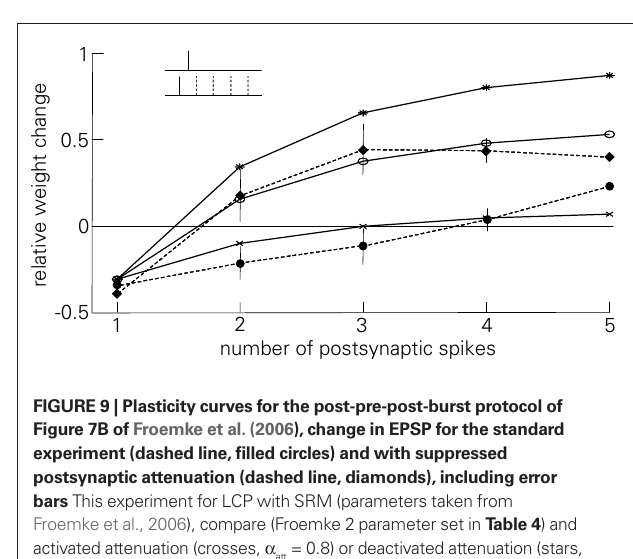
FigurE 9 | Plasticity curves for the post-pre-post-burst protocol of Figure 7B of Froemke et al. (2006), change in EPSP for the standard experiment (dashed line, filled circles) and with suppressed postsynaptic attenuation (dashed line, diamonds), including error bars This experiment for LCP with SRM (parameters taken from Froemke et al., 2006), compare (Froemke 2 parameter set in Table 4 ) and activated attenuation (crosses, α = 0.8) or deactivated attenuation (stars, att = 0); For comparison: standard STDP (empty circles), same parameters as α att LCP with